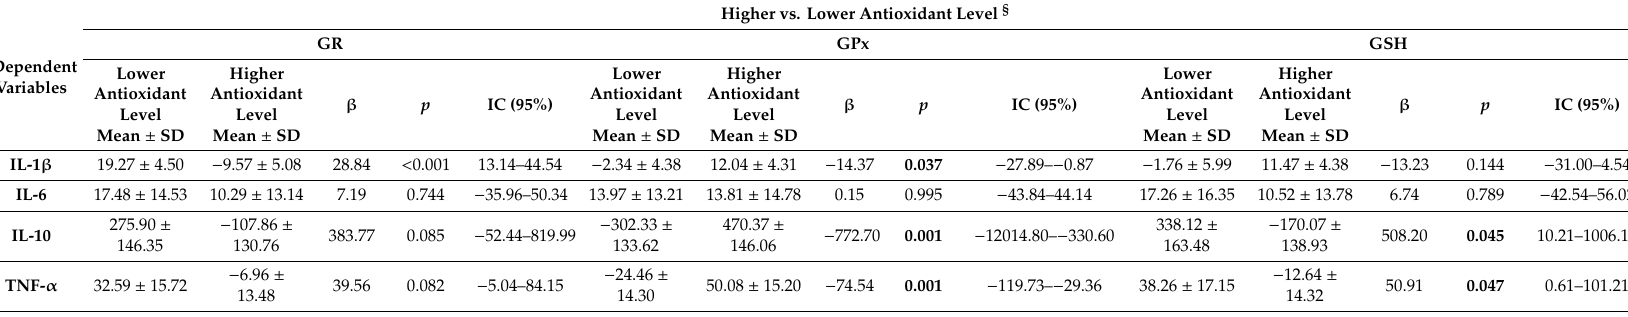
Higher vs. Lower Antioxidant Level §